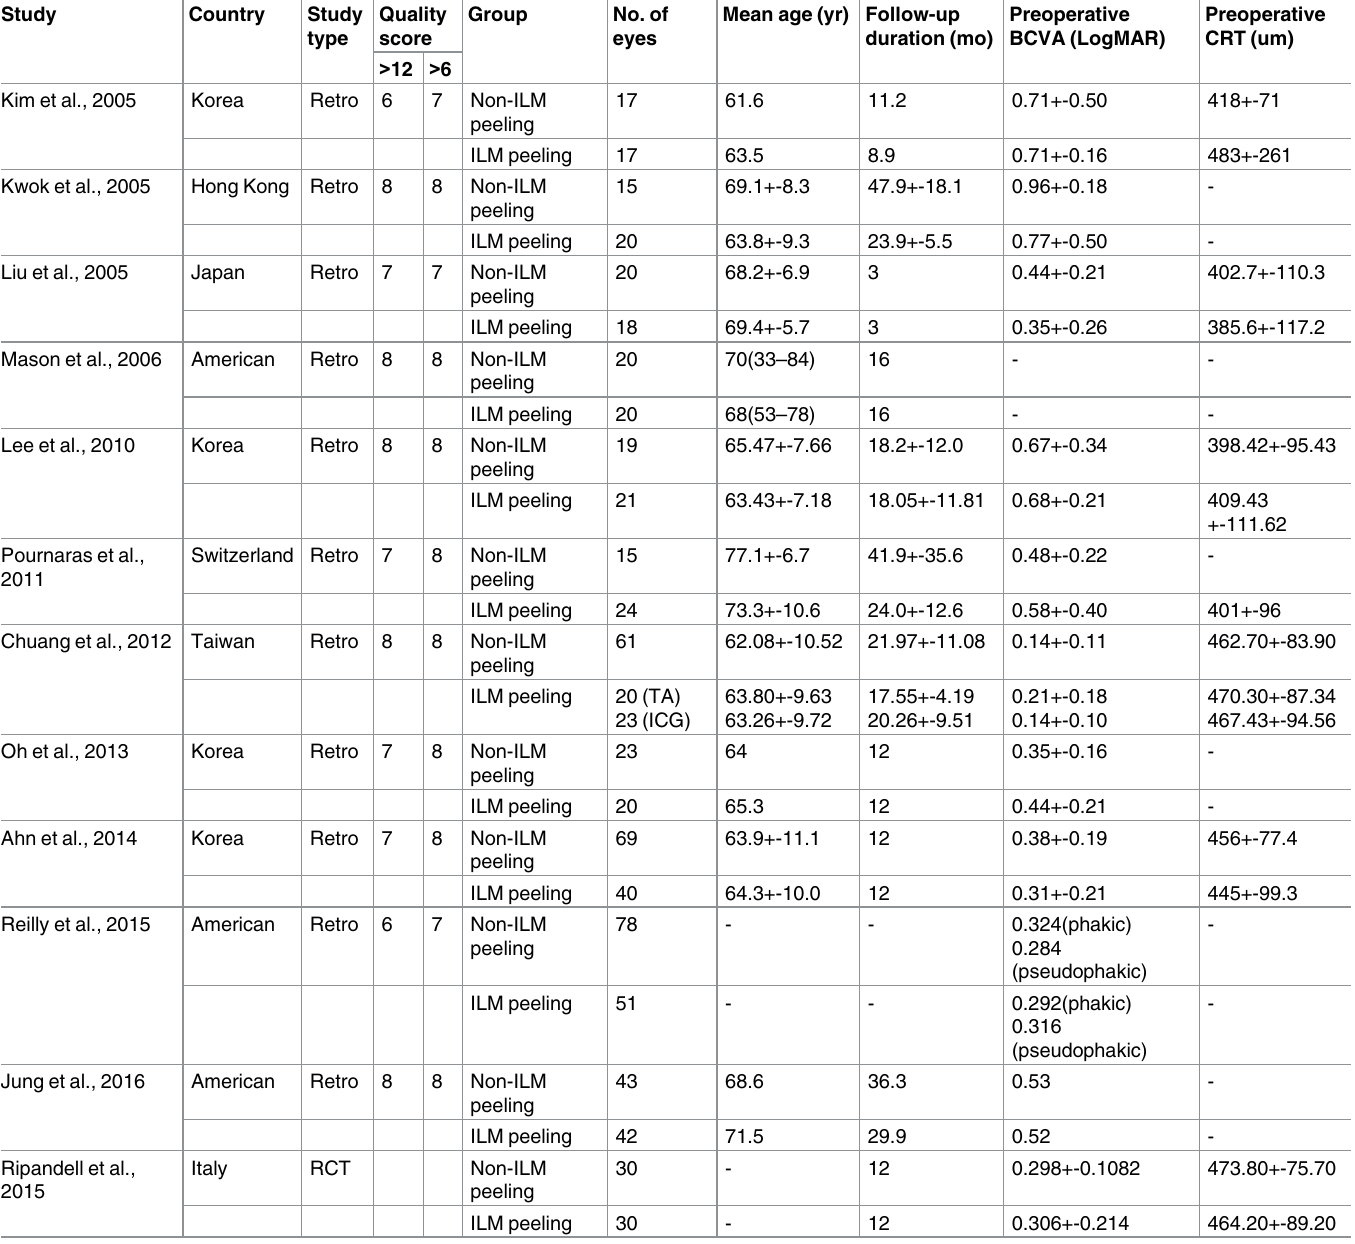
Table 1. Summaryof studies included in the